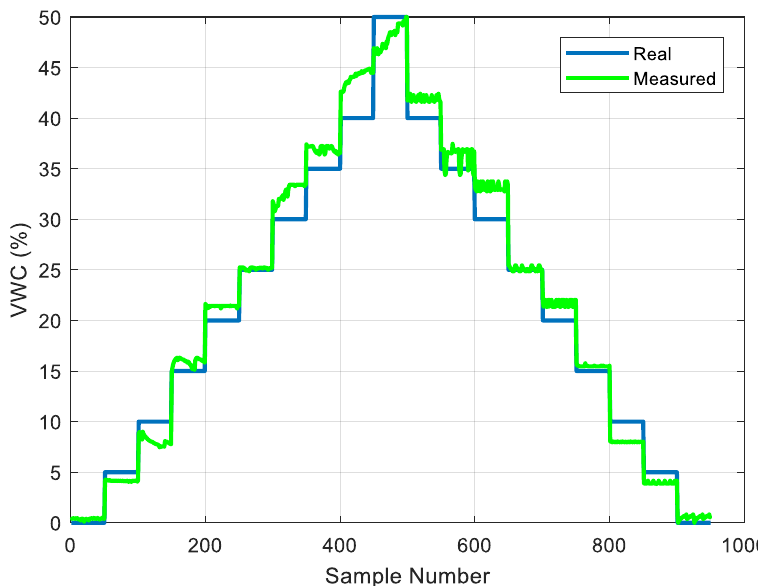
Figure 14. Comparison of real volumetric water content (VWC) and that obtained with the sensor [71].